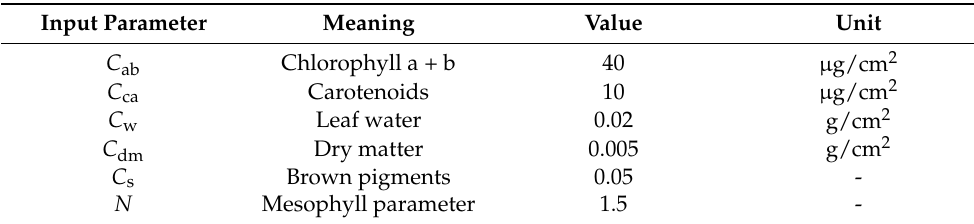
Table 2. Input parameters for spectral simulation with leaf model